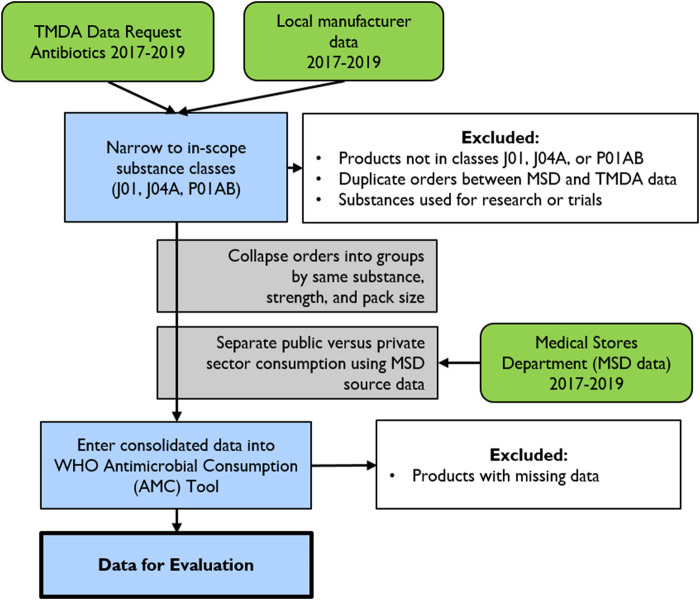
Data collection and cleaning methodology for the Tanzania national antibiotic consumption analysis.